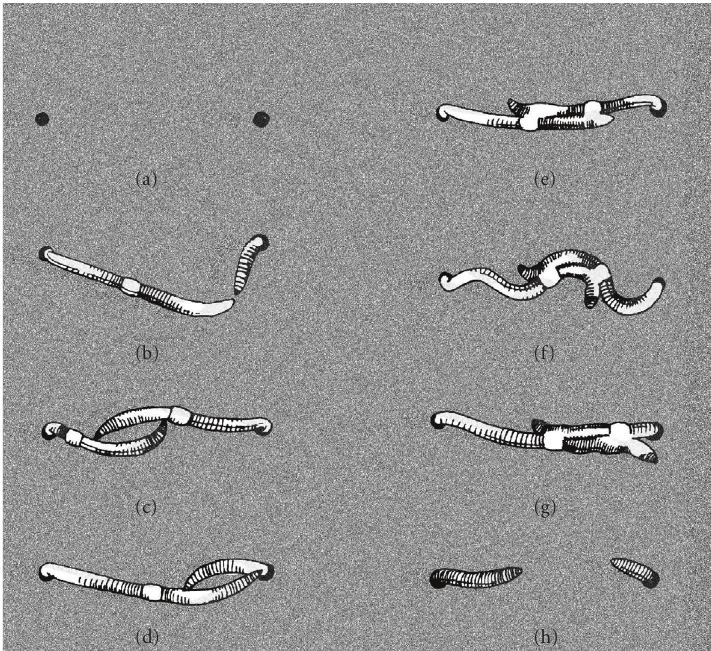
Figure 5: Precopulatory behaviour and mating in the common earthworm ( Lumbricus terrestris ), observed during dark summer nights with special equipment. Both partners remain anchored in their burrows (distance of the holes ca. 7 to 8 cm) (a) and evaluate each other in an extensive courtship process (b), (c), (d). Copulation occurs via the reciprocal attachment of the clitella (see Figure 4) and results in the exchange of sperm (e), (f), (g). After 1 to 3 hours the worms separate and retreat into their burrows (h) (adapted from